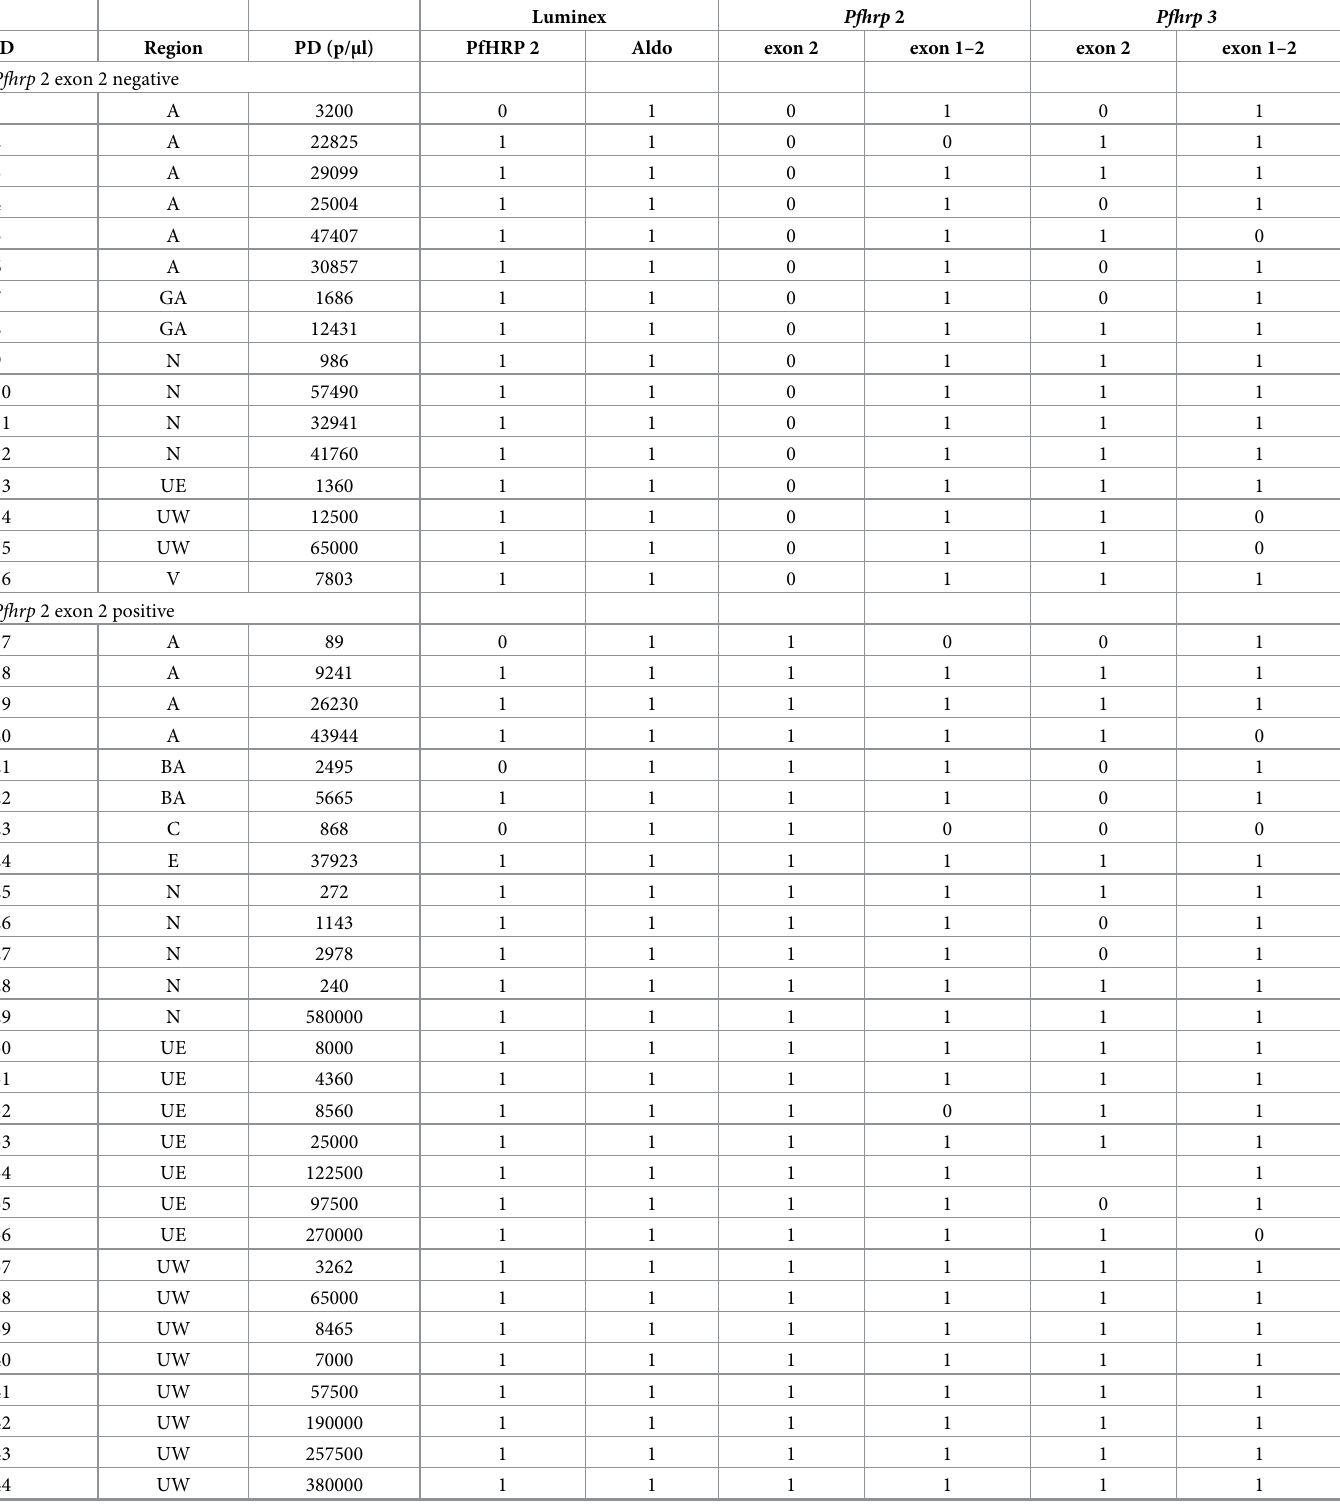
Table 5. Regional distribution of Pfhrp 2/3 negative parasites in aldolase positive